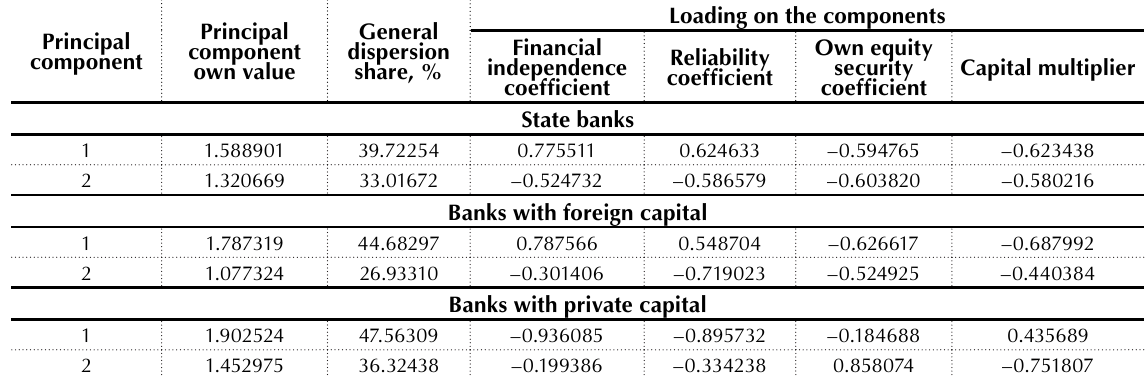
Table 2. Results of using the principal components method for defining the most informative indicators of capital adequacy for assessing the financial stability of different groups of banks